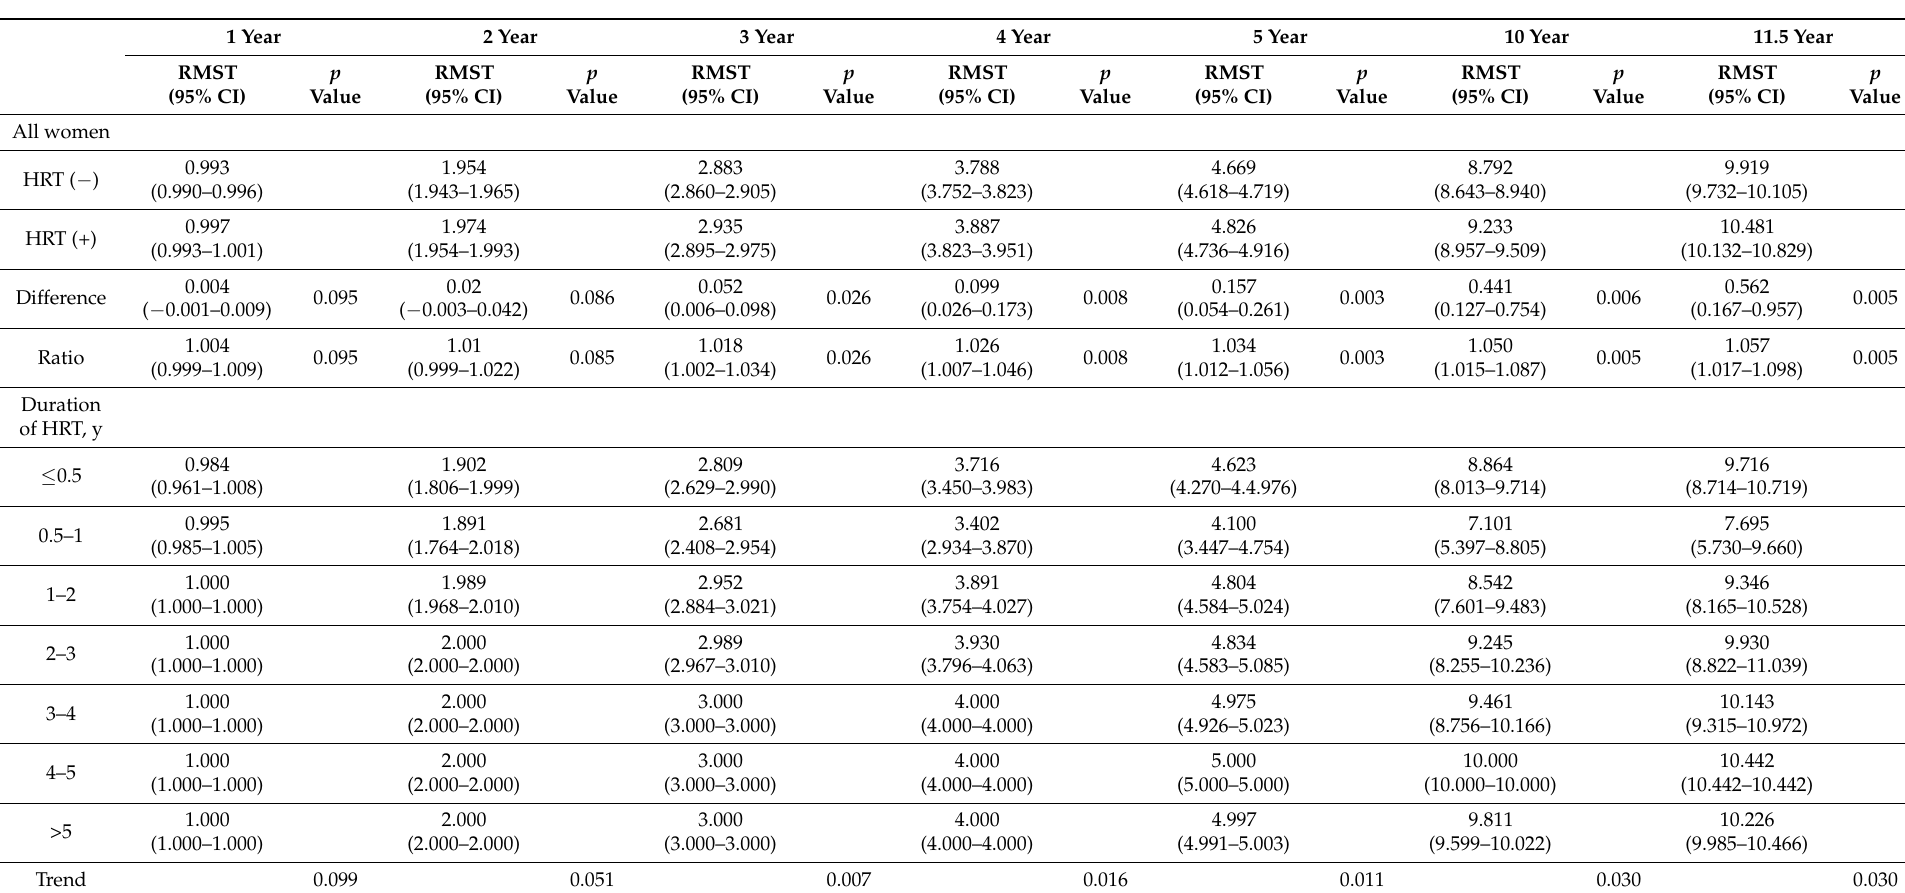
Table 3. RMSTs according to HRT use and duration in women with ovarian